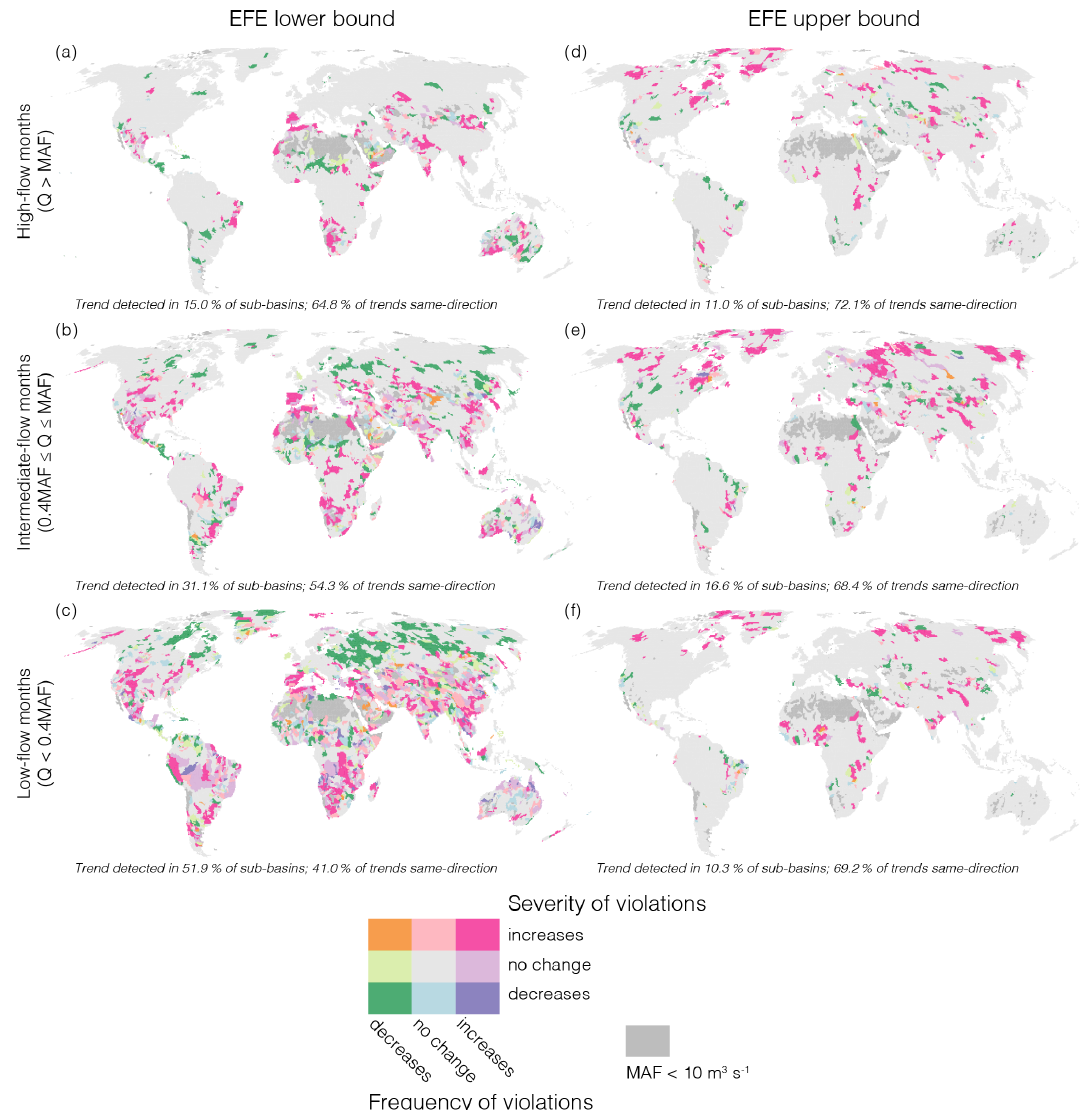
Figure 4. Trends of frequency and severity of environmental flow envelope (EFE) violations of the lower bound (a–c) and the upper bound (d–f) . Q stands for monthly discharge and MAF for mean annual flow. The trends are computed using 5-year moving windows from 1976 to 2005; only statistically significant trends are shown. Same-direction trends are defined as having both frequency and severity trends in the same direction, i.e. both violation frequency and severity are increasing or decreasing. The steepness of the trend slope is not considered here but the trends are classified only by increasing or decreasing